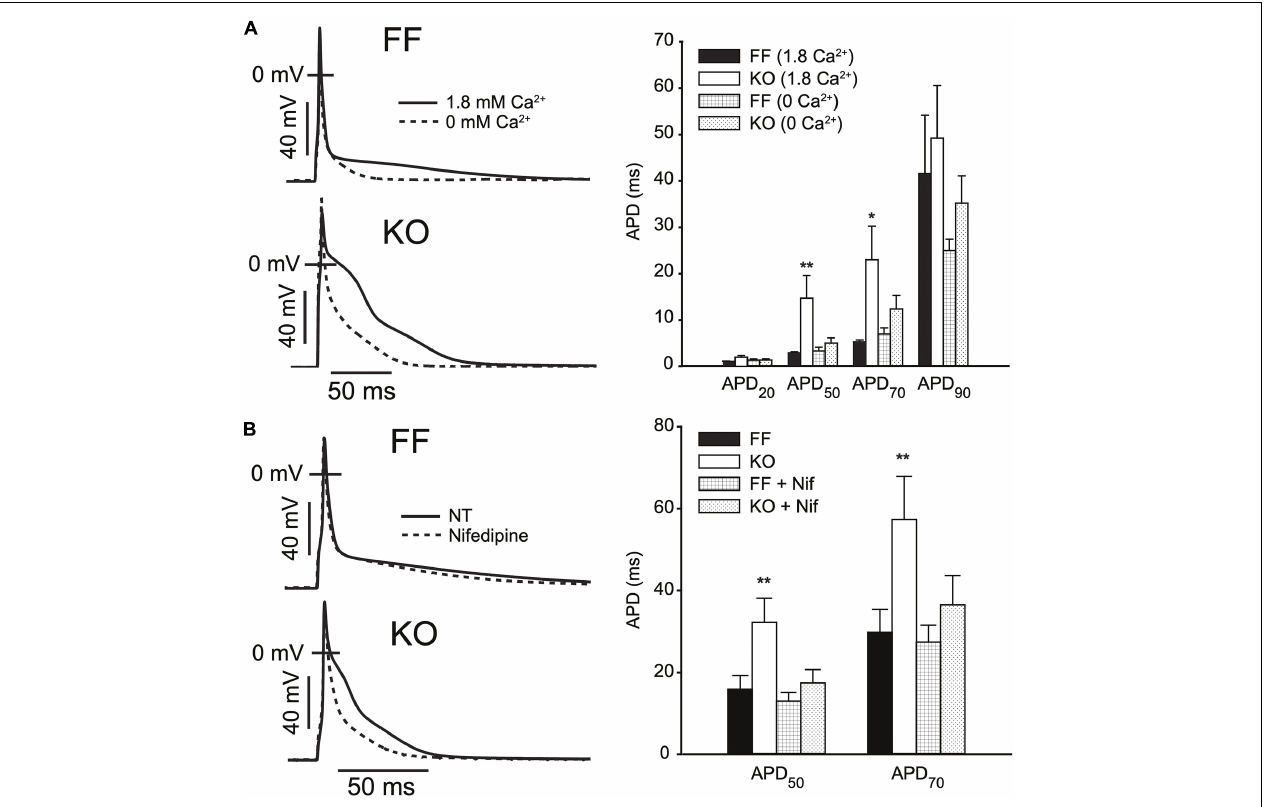
FIGURE 3 | AP prolongation in SERCA2-KO myocytes relies upon augmented L-type calcium current. (A) Superfusing FF ( n = 7) and KO ( n = 8) myocytes with nominally Ca 2 + free extracellular solution abolishes early AP prolongation in KO myocytes, while elevating extracellular Ca 2 + to 1.8 mM exaggerates the difference in APD 50 and APD 70 (** p < 0.05 FF vs. KO at 1.8 mM Ca 2 + ; and p < 0.05 KO at 1.8 mM vs. 0 mM Ca 2 + , * p < 0.0 KO at 1.8 mM vs. 0 mM Ca 2 + ). (B) I CaL blockade via Nifedipine (1 µ M) achieves similar normalization of APD 50 and APD 70 in KO myocytes ( n = 7) relative to FF ( n = 7). ** p < 0.05 FF vs. KO in control superfusate; and p < 0.05 KO in control vs. Nifedipine. All panels: data are means ±